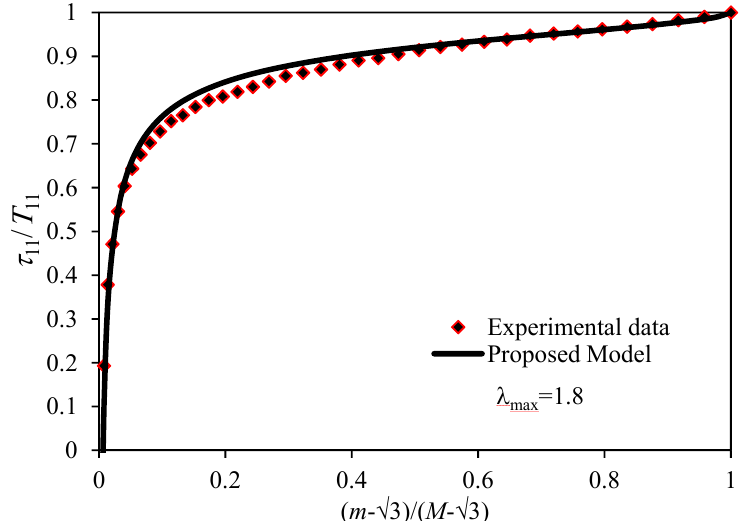
Figure 10. Comparison of experimental data and the normalized predicted material stresses / T  for the first cycle of loading and unloading for the PBR-CB composite 11 11